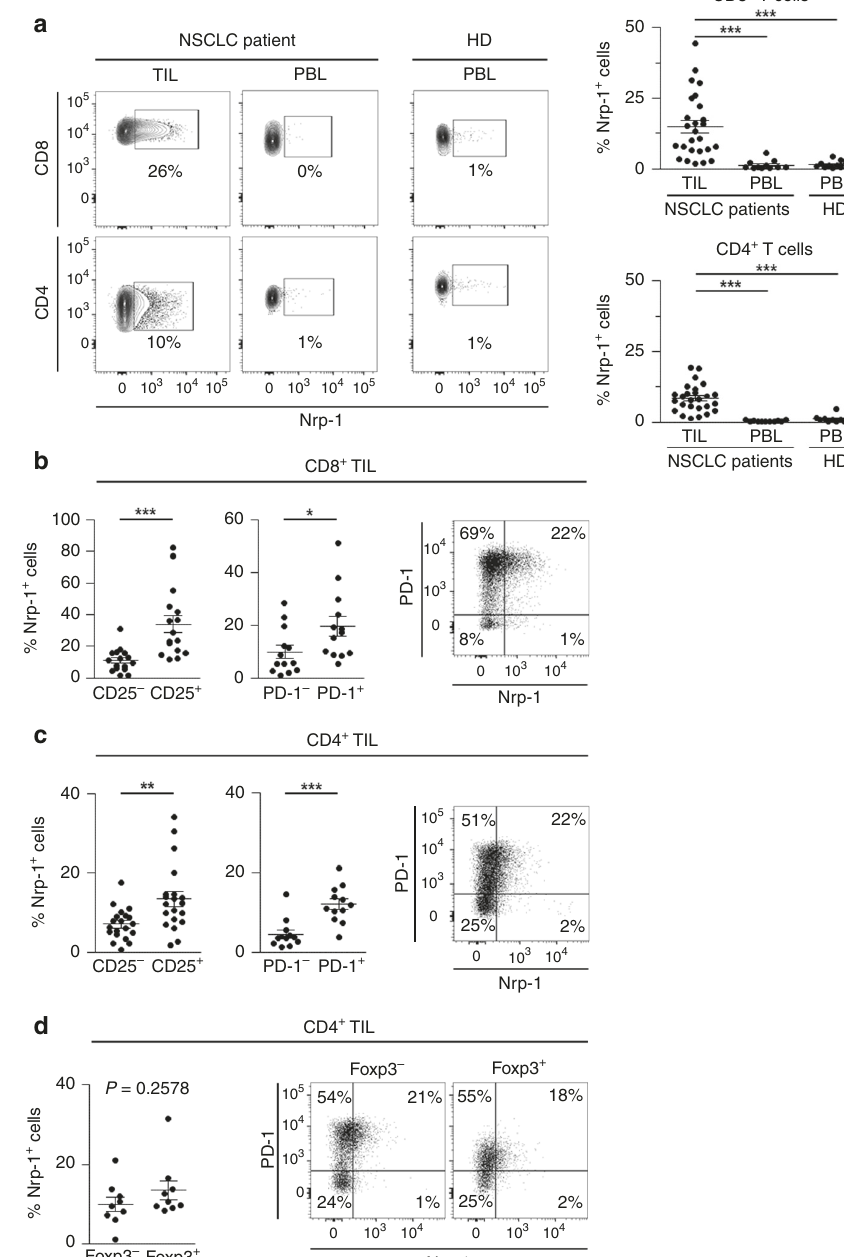
Fig. 1 Expression of Nrp-1 and PD-1 on T cells in fi ltrating human NSCLC tumours. a Surface expression of Nrp-1 on CD4 + and CD8 + T cells from TIL and PBL of NSCLC patients, and compared with PBL from HD. Percentages of positive cells are indicated. Right: percentages of Nrp-1 on CD8 + and CD4 + T cells in TIL ( n = 28) and PBL from NSCLC patients ( n = 11) and HD ( n = 12). b Expression of Nrp-1 in CD25 and PD-1 CD8 + T cells subsets from NSCLC TIL. Percentages of Nrp-1 among CD8 + TIL expressing or not CD25 ( n = 16) or PD-1 ( n = 13). Right: dot plot showing co-expression of Nrp-1 and PD-1 on CD8 + TIL from one representative patient. c Expression of Nrp-1 in CD25 and PD-1 CD4 + T cells subsets from NSCLC TIL. Percentages of Nrp-1 among CD4 + TIL expressing or not CD25 ( n = 20) or PD-1 ( n = 12). Right: dot plot showing co-expression of Nrp-1 and PD-1 on CD4 + TIL from one representative patient. d Expression of Nrp-1 in conventional and regulatory CD4 + T cells subsets. Percentages of Nrp-1 among CD4 + TIL expressing or not FoxP3 ( n = 9). Right: dot plot showing co-expression of Nrp-1 and PD-1 on CD4 + TIL expressing or not FoxP3 from one representative patient. Means ± SEM one-way ANOVA test with Bonferroni correction a or two-tailed Student ’ s unpaired t test b , c , d . * P < 0.05; ** P < 0.01; *** P <